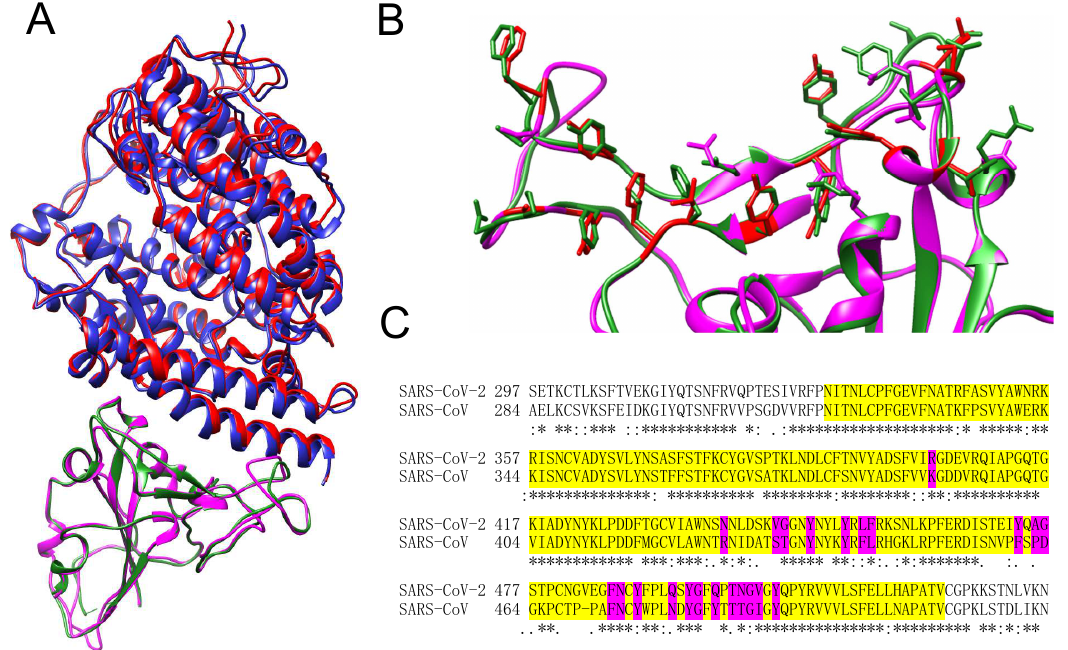
Figure 1. Protein-protein docking with SARS-CoV-2 receptor binding domain (RBD) and human angiotensin-converting enzyme II (ACE2). ( A ) Structural comparison between the predicted SARS-CoV-2 RBD-ACE2 complex and the experimental SARS-CoV RBD-ACE2 structure (PDB code: 3SCI). SARS-CoV-2 RBD is colored magenta and its interacting ACE2 is colored blue. SARS-CoV RBD is colored green and its interacting ACE2 is colored red, respectively. ( B ) The binding site residues on the RBD that are within 5.0 Å form the ACE2, where the hydrophobic residues on the SARS-CoV-2 RBD are highlighted in red. ( C ) Part of the sequence alignment between the spike proteins of SARS-CoV-2 and SARS-CoV, where the RBD residues are highlighted in yellow and the residues at the binding site are highlighted in magenta, respectively.